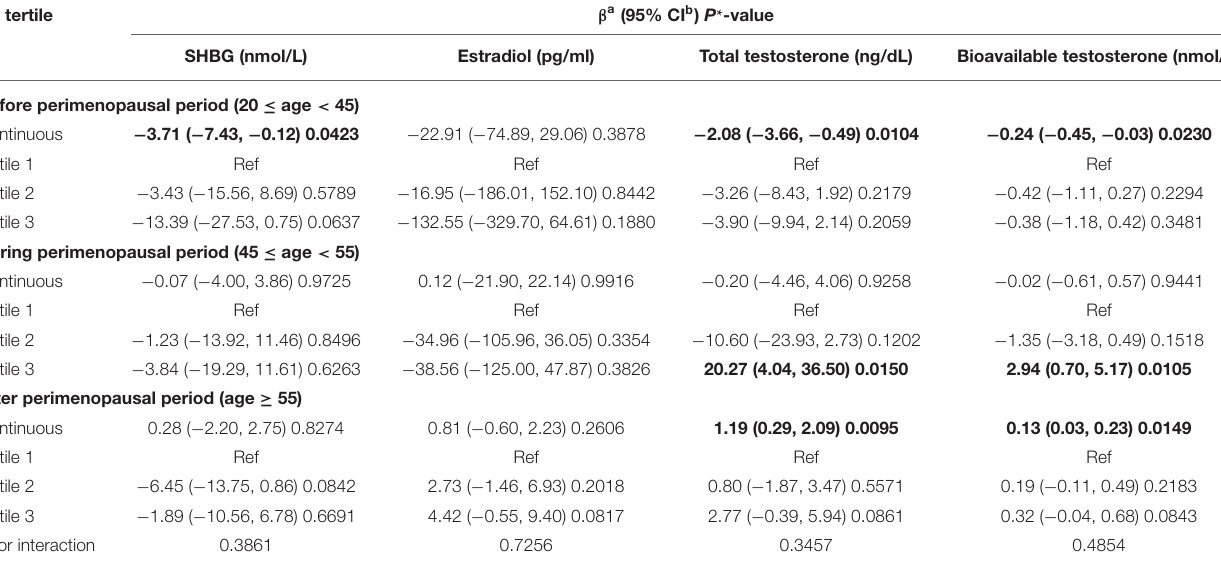
TABLE 4 | Perimenopausal period–stratified subgroup analysis of association between dietary inflammatory index and sex hormone & sex hormone binding globulin. DII tertile β a (95% CI b ) P * -value SHBG (nmol/L) Estradiol (pg/ml) Total testosterone (ng/dL) Bioavailable testosterone (nmol/L) Before perimenopausal period (20 ≤ age < 45)